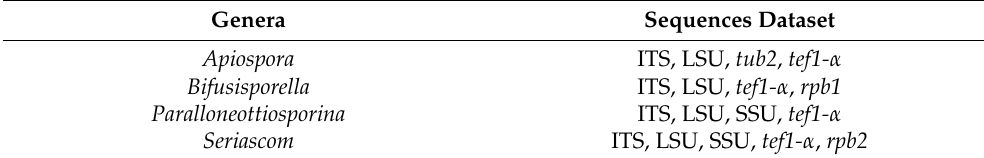
Table 1. Selected genes for polymerase chain reaction of each